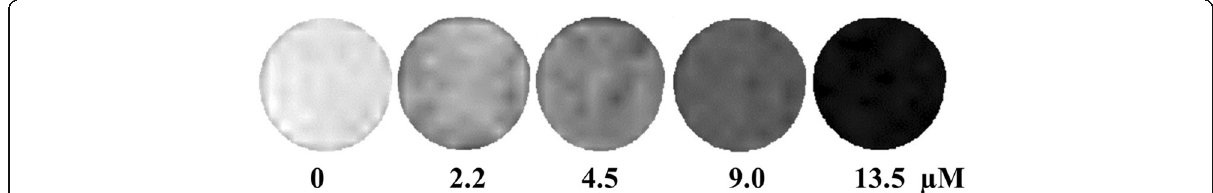
Fig. 8 T 2 -weighted cellular MR images of A549 cells incubated with the Fe 3 O 4 NC/PAH/PSS/DOX hybrid nanostructures at a Fe concentration of 2.2, 4.5, 9.0, and 13.5 μ M,